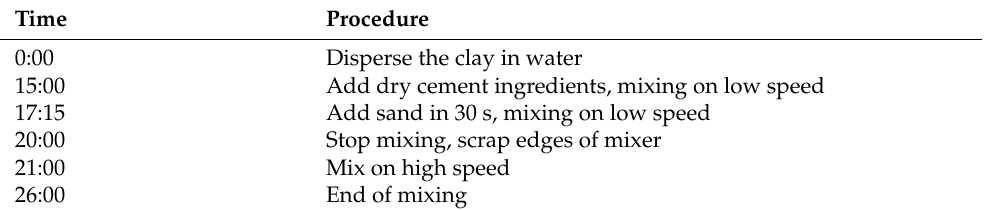
Table 3. Mix protocol for cement mortar.